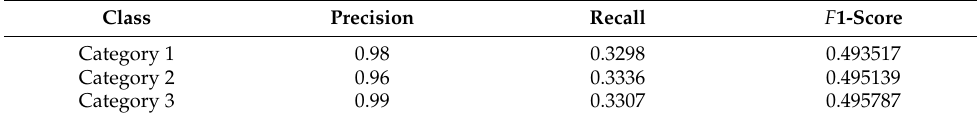
Table 7. Measurement for each